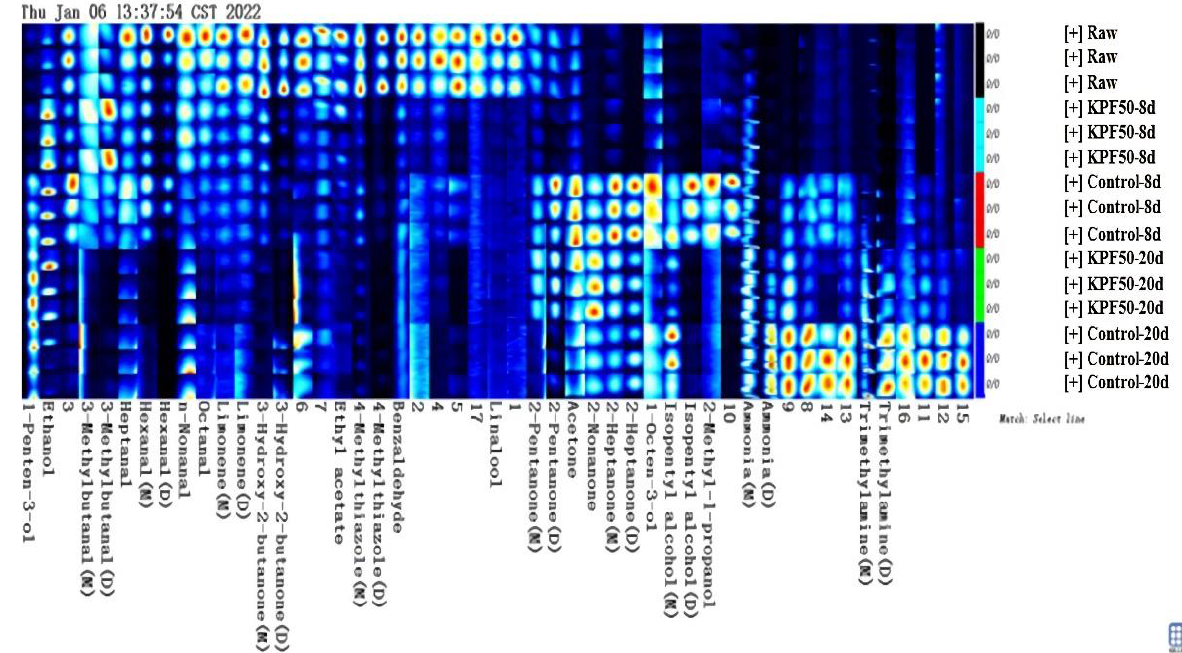
Figure 4. Characteristic peak gallery report of different types of vegetable oil.